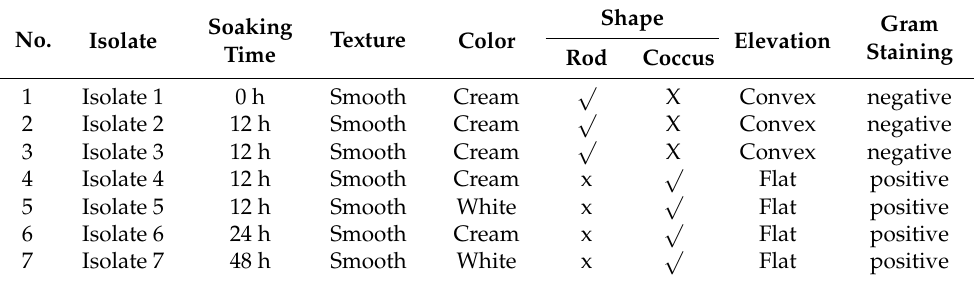
Table 3. Seven bacterial isolates by microscopic and colonial morphology measures.